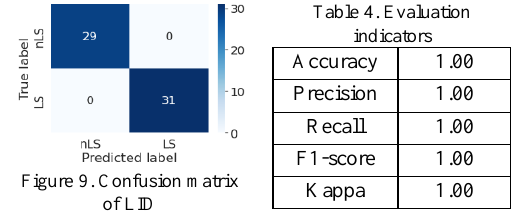
Table 4. Evaluation indicators